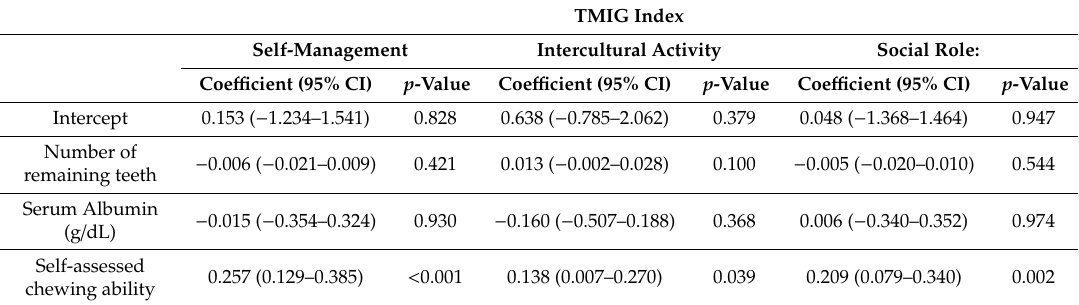
Table 2. Correlations of the number of remaining teeth, serum albumin, and self-assessed chewing ability with the IADL.